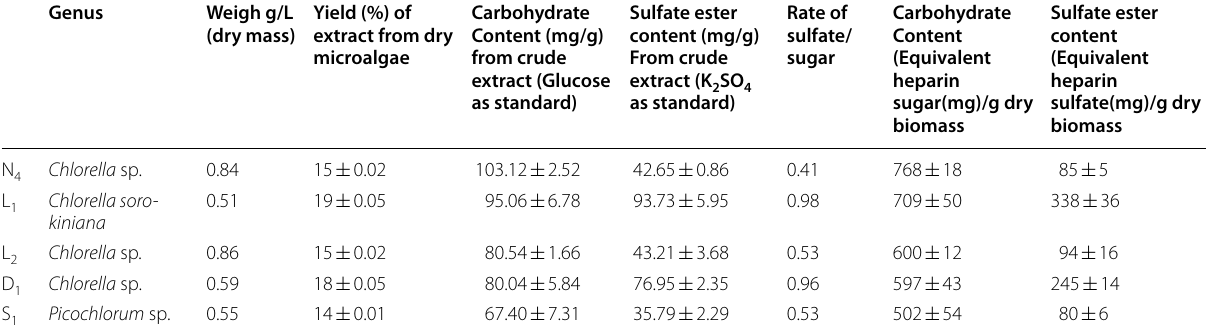
Table 2 Physio-chemical characteristics of biomass microalgae strains and EPS extracted by comparing heparin sodium and glucose standard (Value expressed as mean SD) ± Genus Weigh g/L Yield (%) of (dry mass) extract from